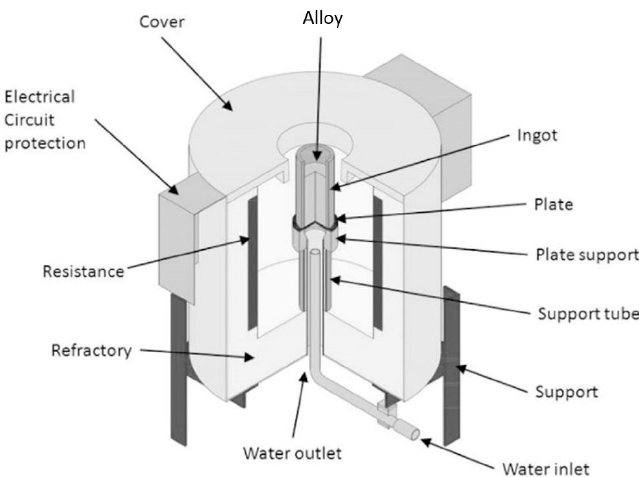
Figure 3. Schematic illustration of the upward unidirectional solidification furnace [14].